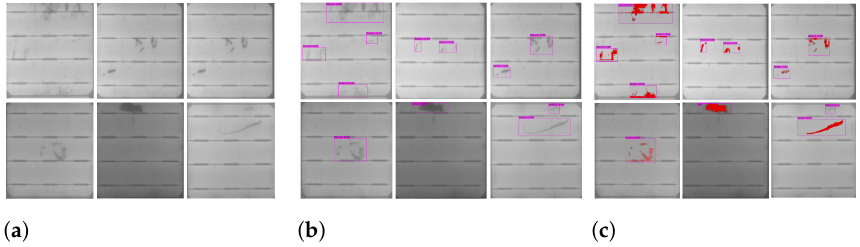
Figure 5. Procedure for defect detection and pseudo-colorization. ( a ) Selecting segmented cells for defect detection. ( b ) Defects detected by detector. ( c ) Pseudo-Colorization of defects.